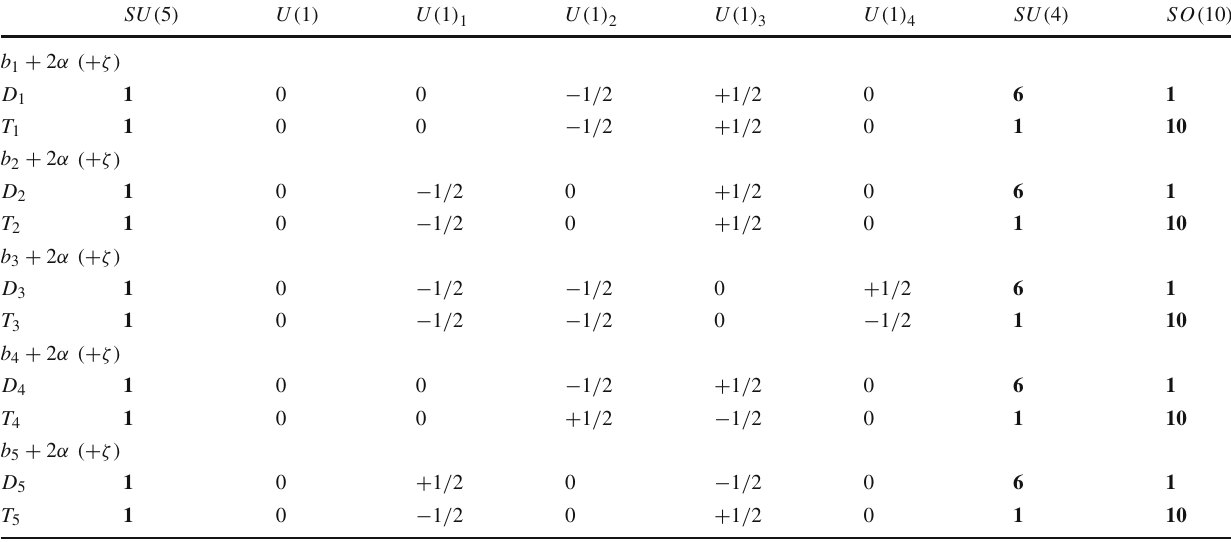
Table 3 “Hidden sector” massless matter states and their SU ( 5 ) × U ( 1 ) × U ( 1 ) 4 × SU ( 4 ) × SO ( 10 ) quantum numbers